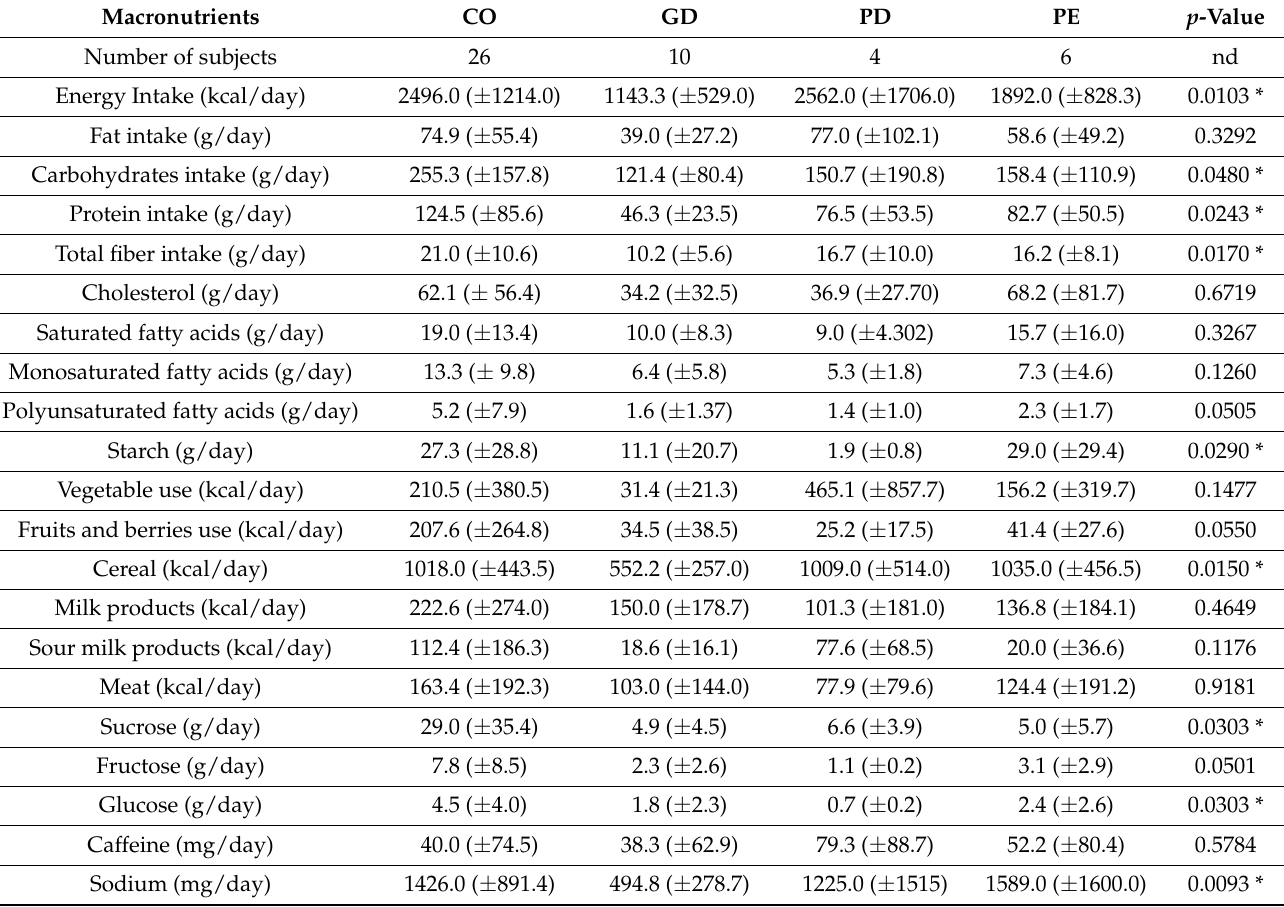
Table 2. Nutrimental data for participants in the study by